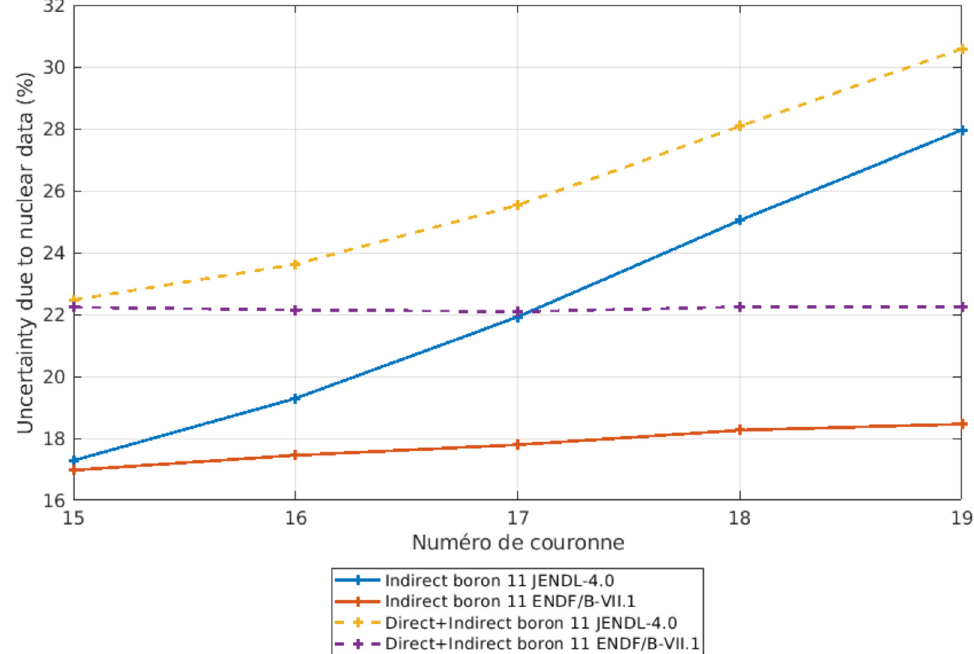
Fig. 35. Total uncertainty due to nuclear data on the production of tritium particles in the neutron shielding